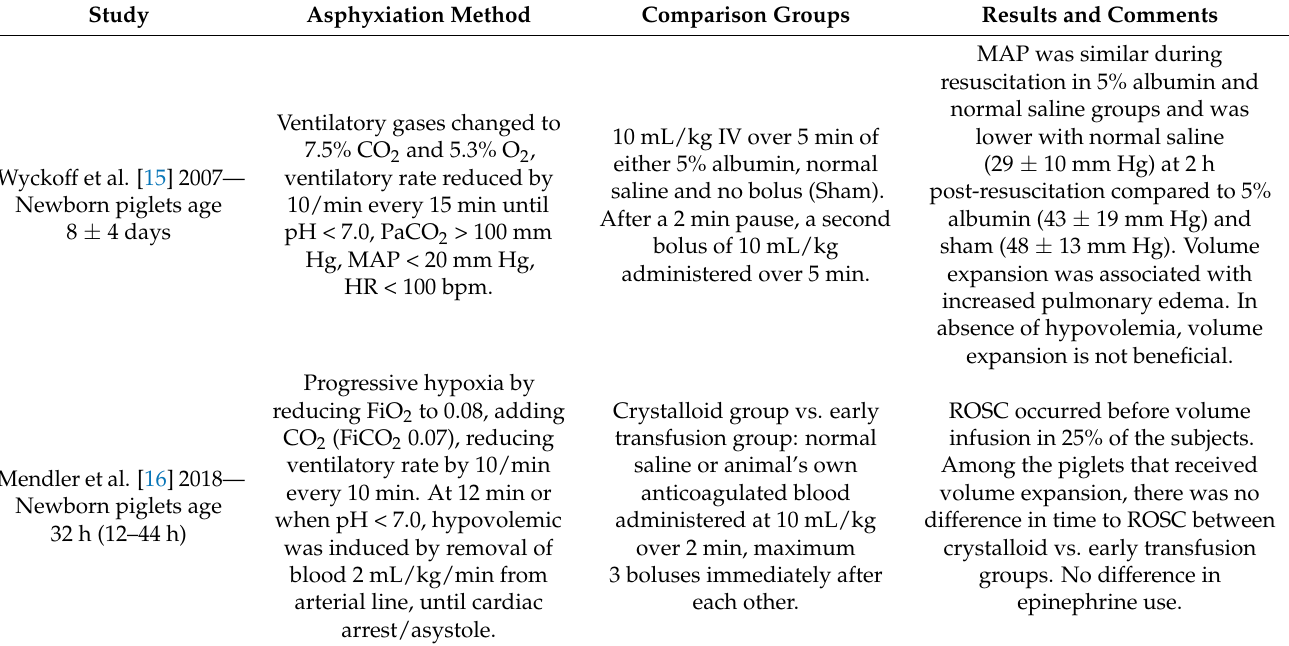
Table 1. Summary of animal studies evaluating volume replacement in the delivery